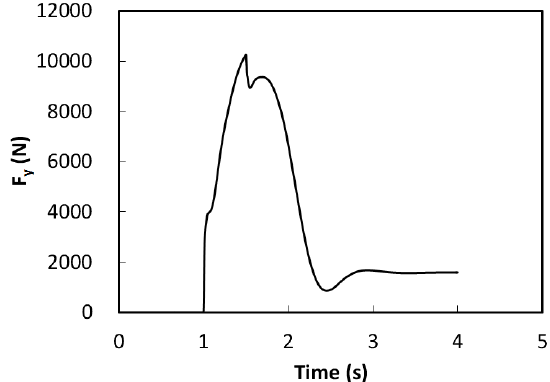
Figure 26. Total lateral force with upper level